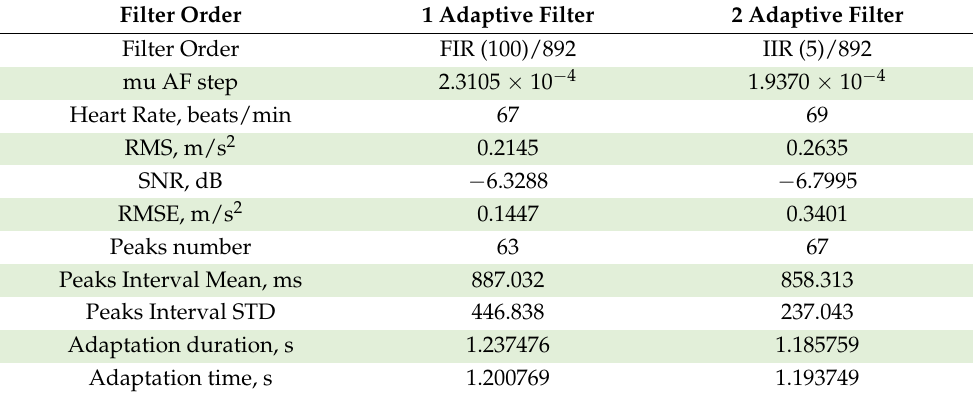
Table 4. Modeled SCG signal processing